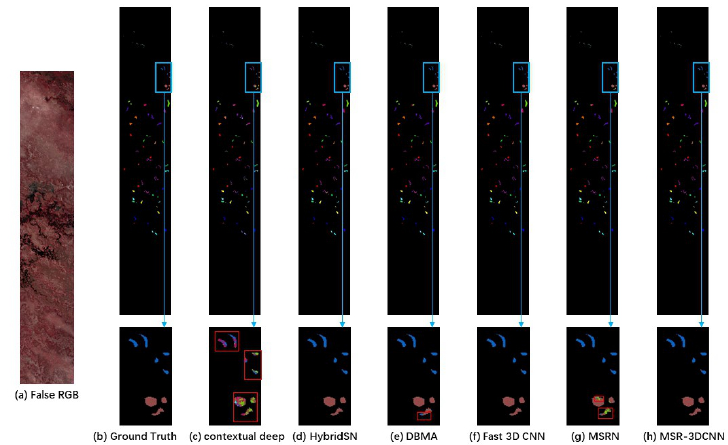
Figure 10. Results of the BO dataset using 10% samples for training and ( 9 × 9 ) patch size.